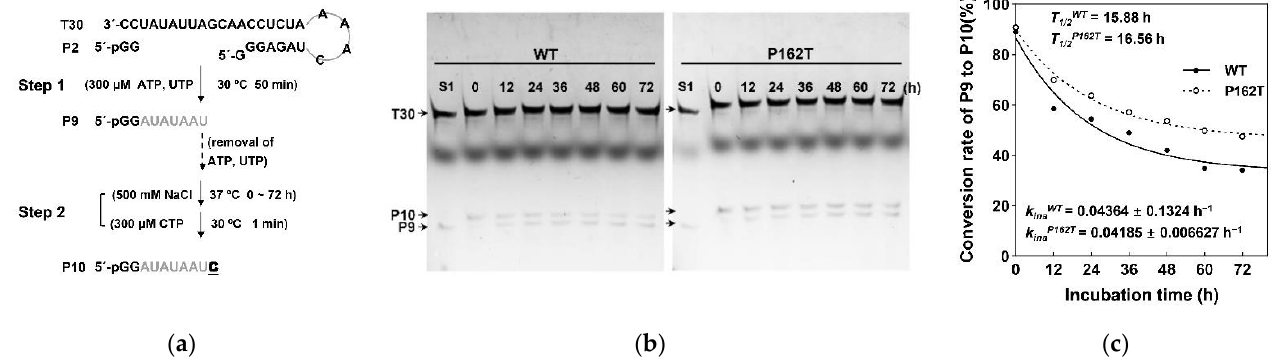
Figure 5. The stability of the RdRp elongation complex. ( a ) Schematic diagram of the stability assay. The first step of the assay was identical to the de novo RdRp assay. In the second step, a high-salt (500 mM NaCl) challenge was added before the supply of CTP. ( b ) Denaturing urea-PAGE analysis of the P9 to P10 conversion. The oval-shaped band between T30 and P10 is the Xylene Cyanol FF. S1, sample from step 1. ( c ) Comparison of stability of EC for NS5B WT and NS5B P162T . The conversion rate of P9 to P10 was plotted as a function of incubation time to estimate the apparent EC inactivation rate constant ( k ina ) and half-life period ( T 1/2 ) by fitting to a one phase exponential decay model.